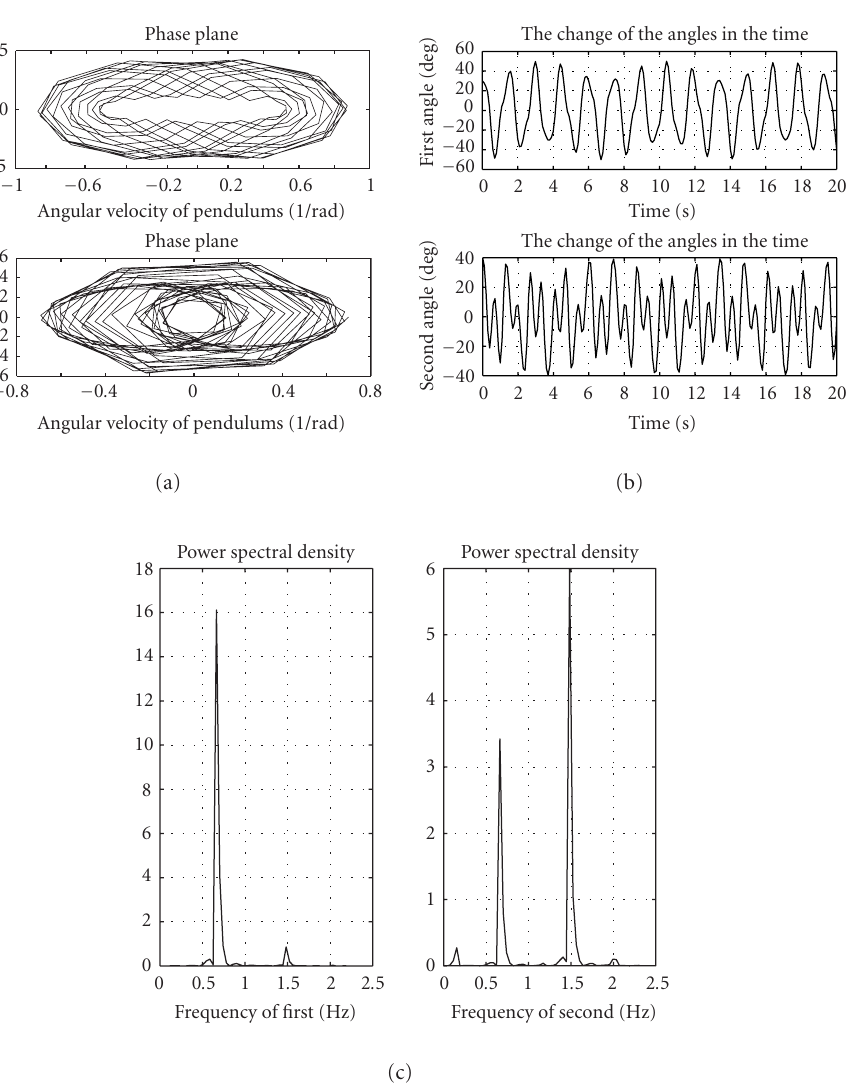
Figure 3.2. (a) “Phase portraits” for the two pendulums; (b) swinging angles ϕ 1 ( t ) and ϕ 2 ( t ); (c) oscillation spectrum distributions for the two pendulums. Parameters are m 1 = m 2 = 1 . 57 kg, L 1 = L 2 = 0 . 3 m, Ψ = 15 ◦ . Initial conditions are ϕ 1 = 30 ◦ , ϕ 2 = 40 ◦